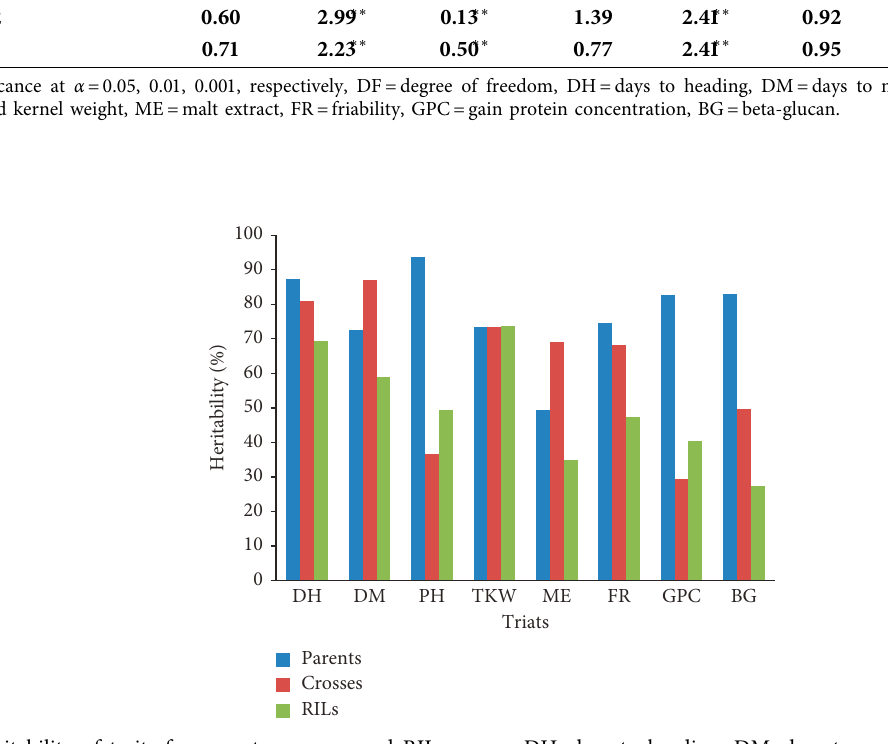
Figure 1: Heritability of traits for parents, crosses, and RILs across. DH � days to heading, DM � days to maturity, PH � plant height, TKW � thousand kernel weight, ME � malt extract, GPC � gain protein concentration, FR � friability, BG � beta-glucan, Hol � Holeta, Bek � Bekoji.